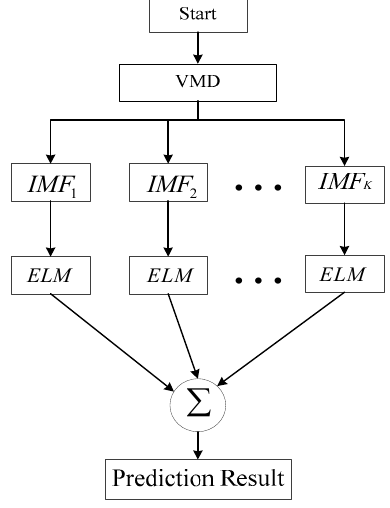
Figure 2. The flowchart of VMD-ELM prediction model.